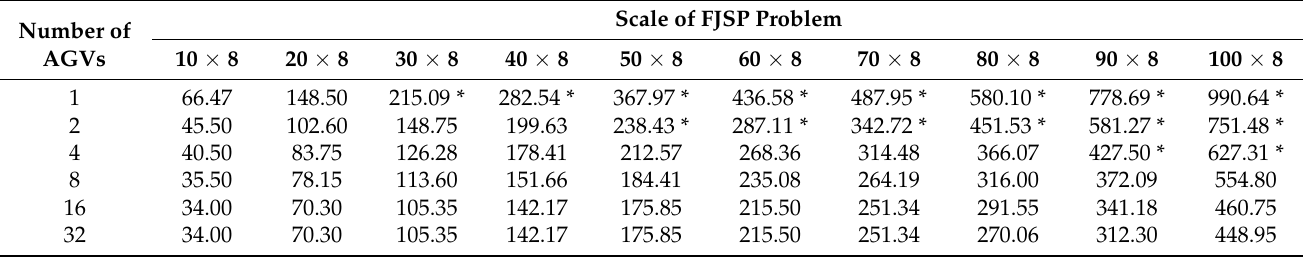
Table 3. Final completion time under different scales of problem and number of AGVs.